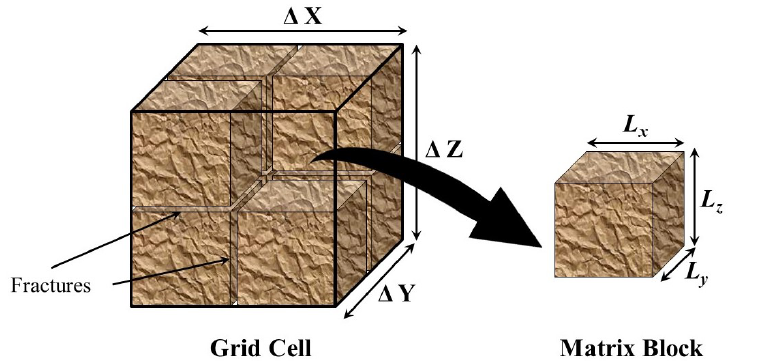
Figure 7. Illustration of the differences between grid cell dimensions ( ∆ X , ∆ Y , ∆ Z ) and matrix block dimensions ( L x , L y , L z ) , which are used in the shape factor calculations as explained in Equation (4). Natural fractures may occur at various spaces which create various sizes of matrix blocks, [6].